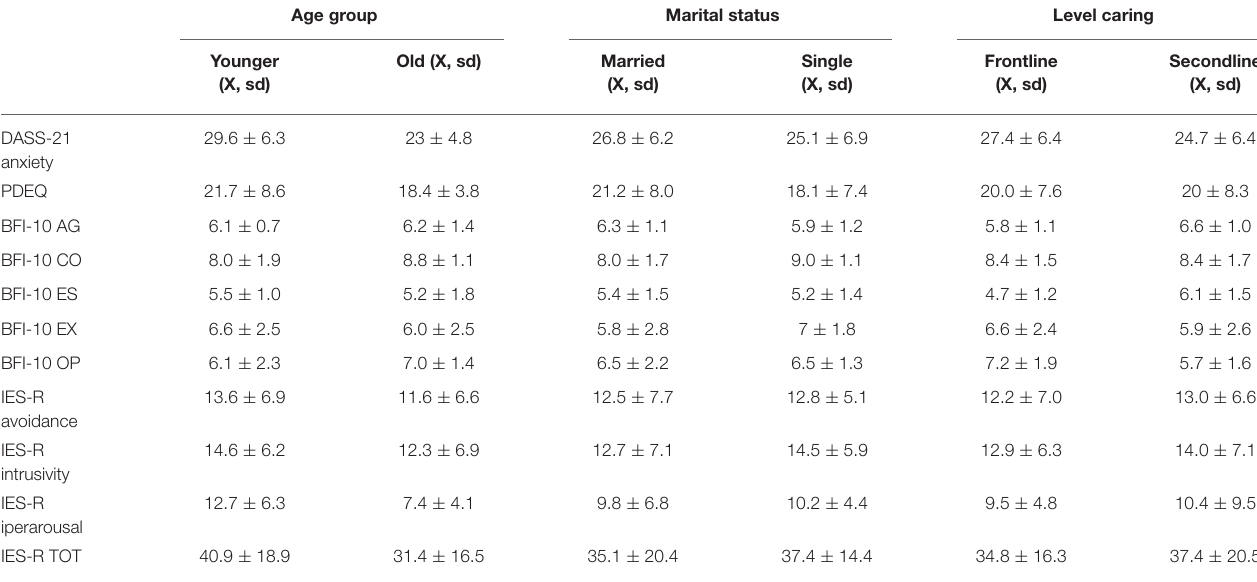
Single Frontline Secondline (X, sd) (X, sd) (X, sd)